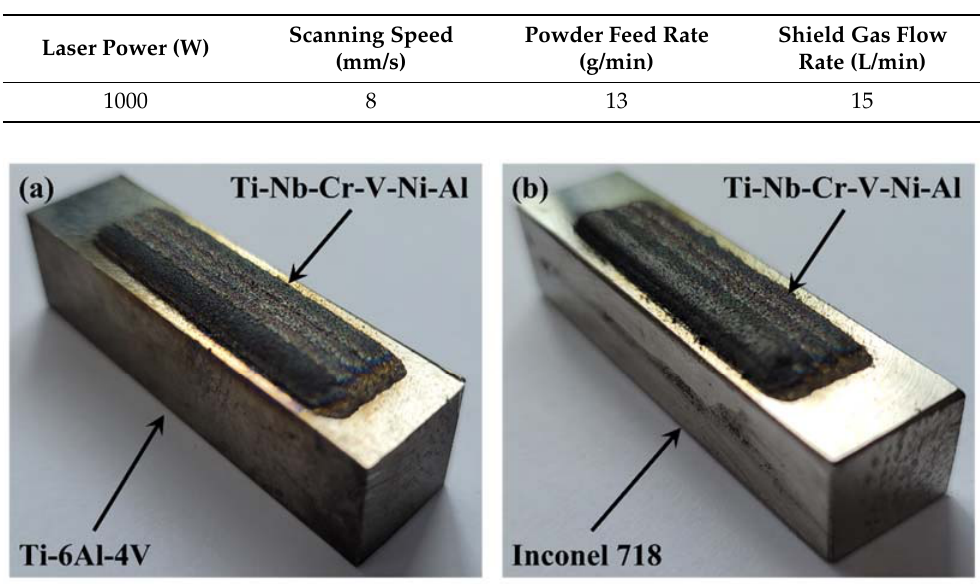
Figure 6. The results for Ti ‐ Nb ‐ Cr ‐ V ‐ Ni ‐ Al: ( a ) Ti ‐ Nb ‐ Cr ‐ V ‐ Ni ‐ Al deposited on Ti ‐ 6Al ‐ 4V and ( b ) Ti ‐ Nb ‐ Cr ‐ V ‐ Ni ‐ Al deposited on Inconel 718.